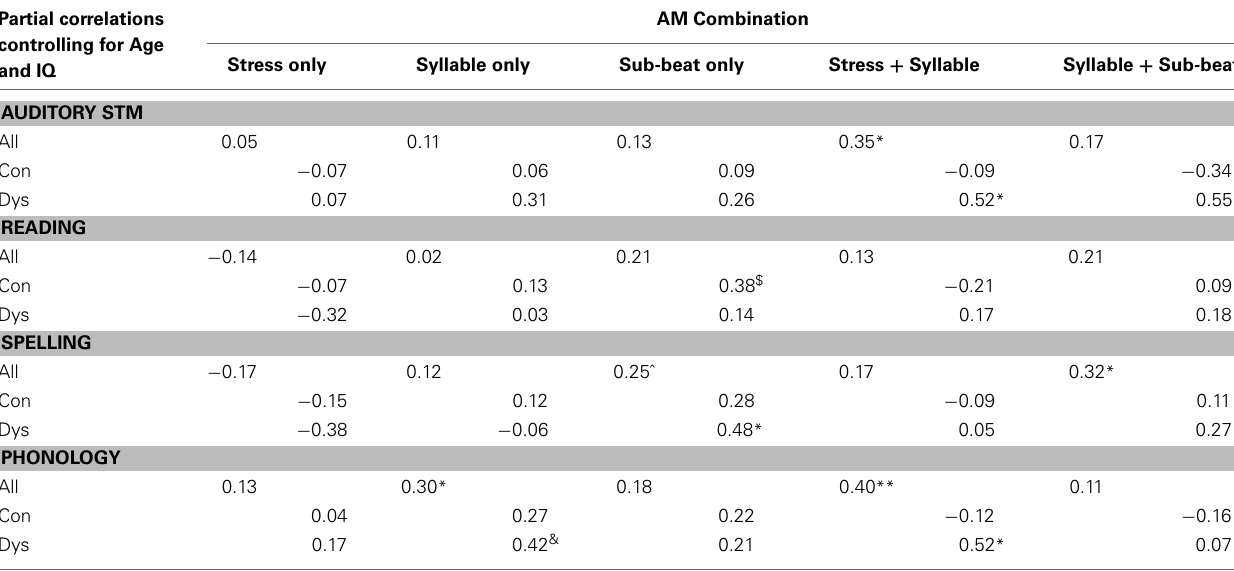
Table 3 | Pearson’s r partial correlation values between accuracy of performance in rhythm perception (by AM type), and general ability, literacy and phonology